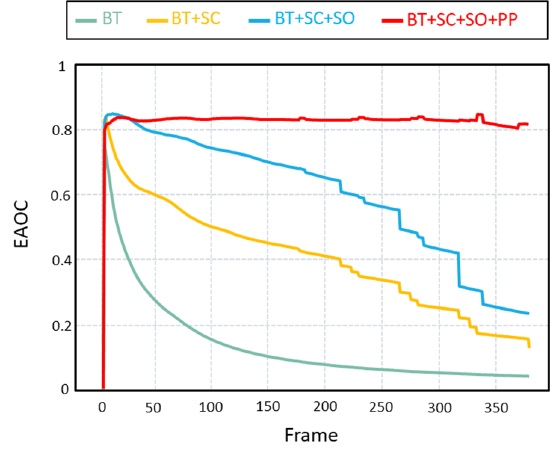
Figure 11. EAOC of tracking models.